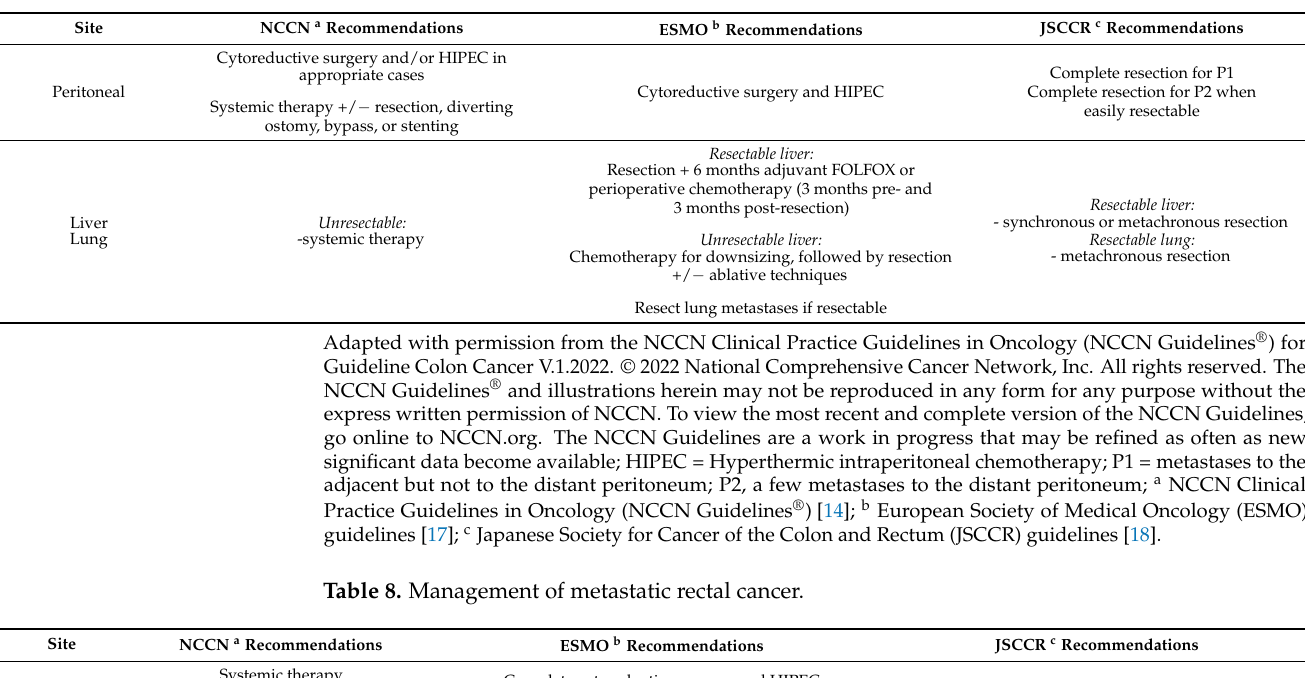
Table 7. Management of metastatic colon cancer.